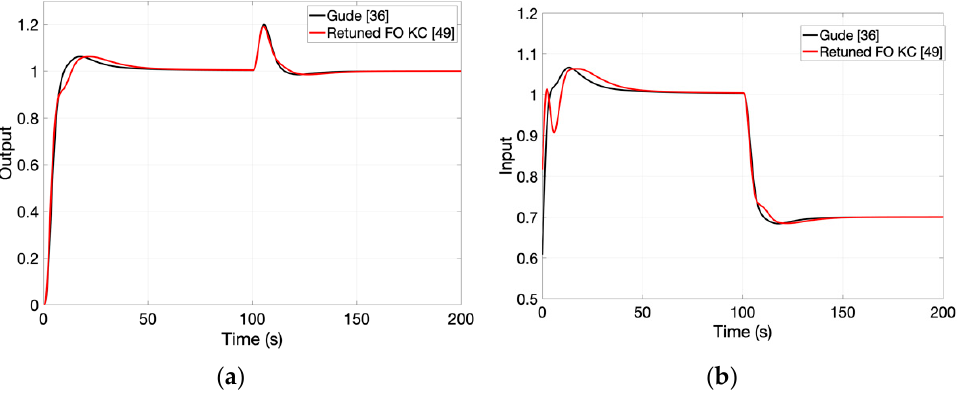
Figure 14. ( a ) Comparative results for the output signals for FO-PID control of higher order process. ( b ) Input signals for FO-PID control of higher order process (controllers tuned according to [36,49])